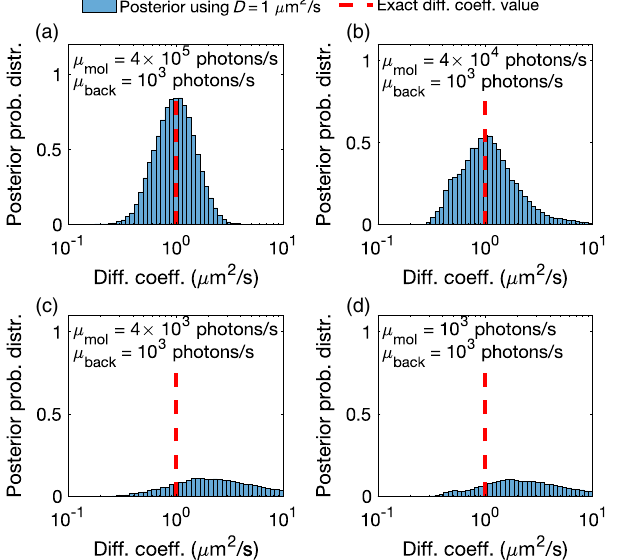
FIG. 8. Higher molecular concentrations in experimental traces provide more photons per unit time resulting in sharper diffusion- coefficient estimates. Estimates shown are drawn from exper- imental traces with a low (100 pM) (a) and high (1 nM) (b) concentration of Cy3 dye molecules and 75% glycerol at a fixed laser power of 100 μ W. Similarly to Fig. 1, we compare our method ’ s diffusion-coefficient estimate (circle green dots) to FCS (blue asterisk) as a function of the number of photons used in the analysis. Since by 1 . 5 × 10 4 photon arrivals our method has converged, we avoid analyzing larger traces. The red dashed line is the FCS estimate produced from the entire 5-min trace containing ≈ 3 × 10 6 photon